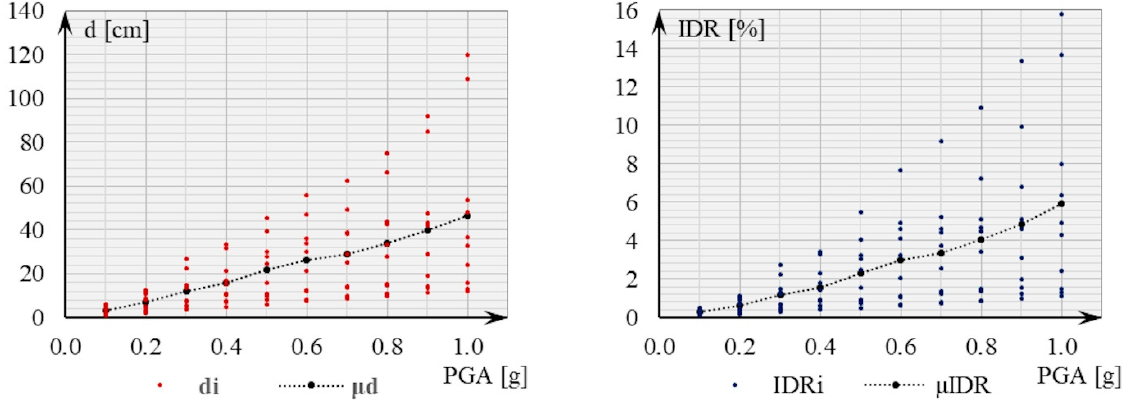
Figure 10. Roof displacement ( left ) and IDR results ( right ) obtained using NDA .